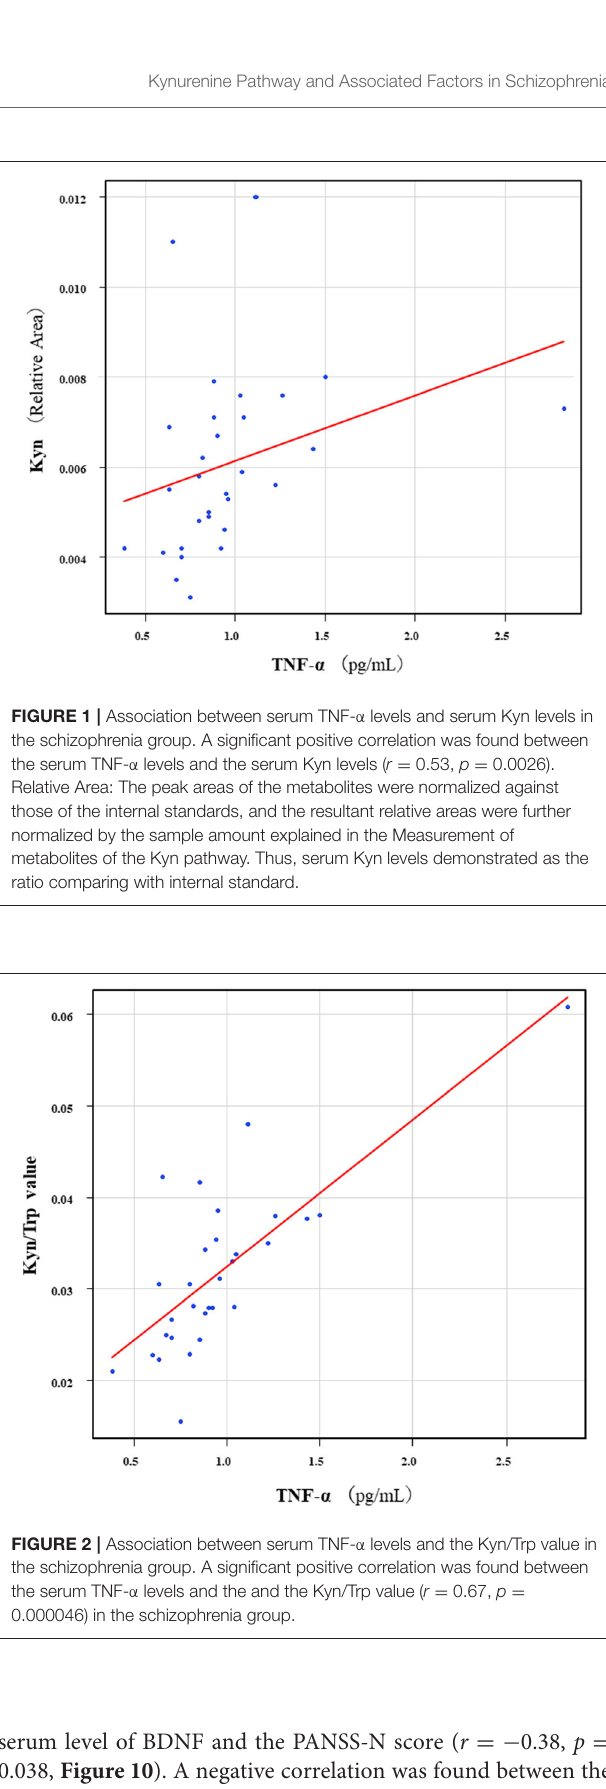
serum level of BDNF and the PANSS-N score ( r = − 0.38, p = 0.038, Figure 10 ). A negative correlation was found between